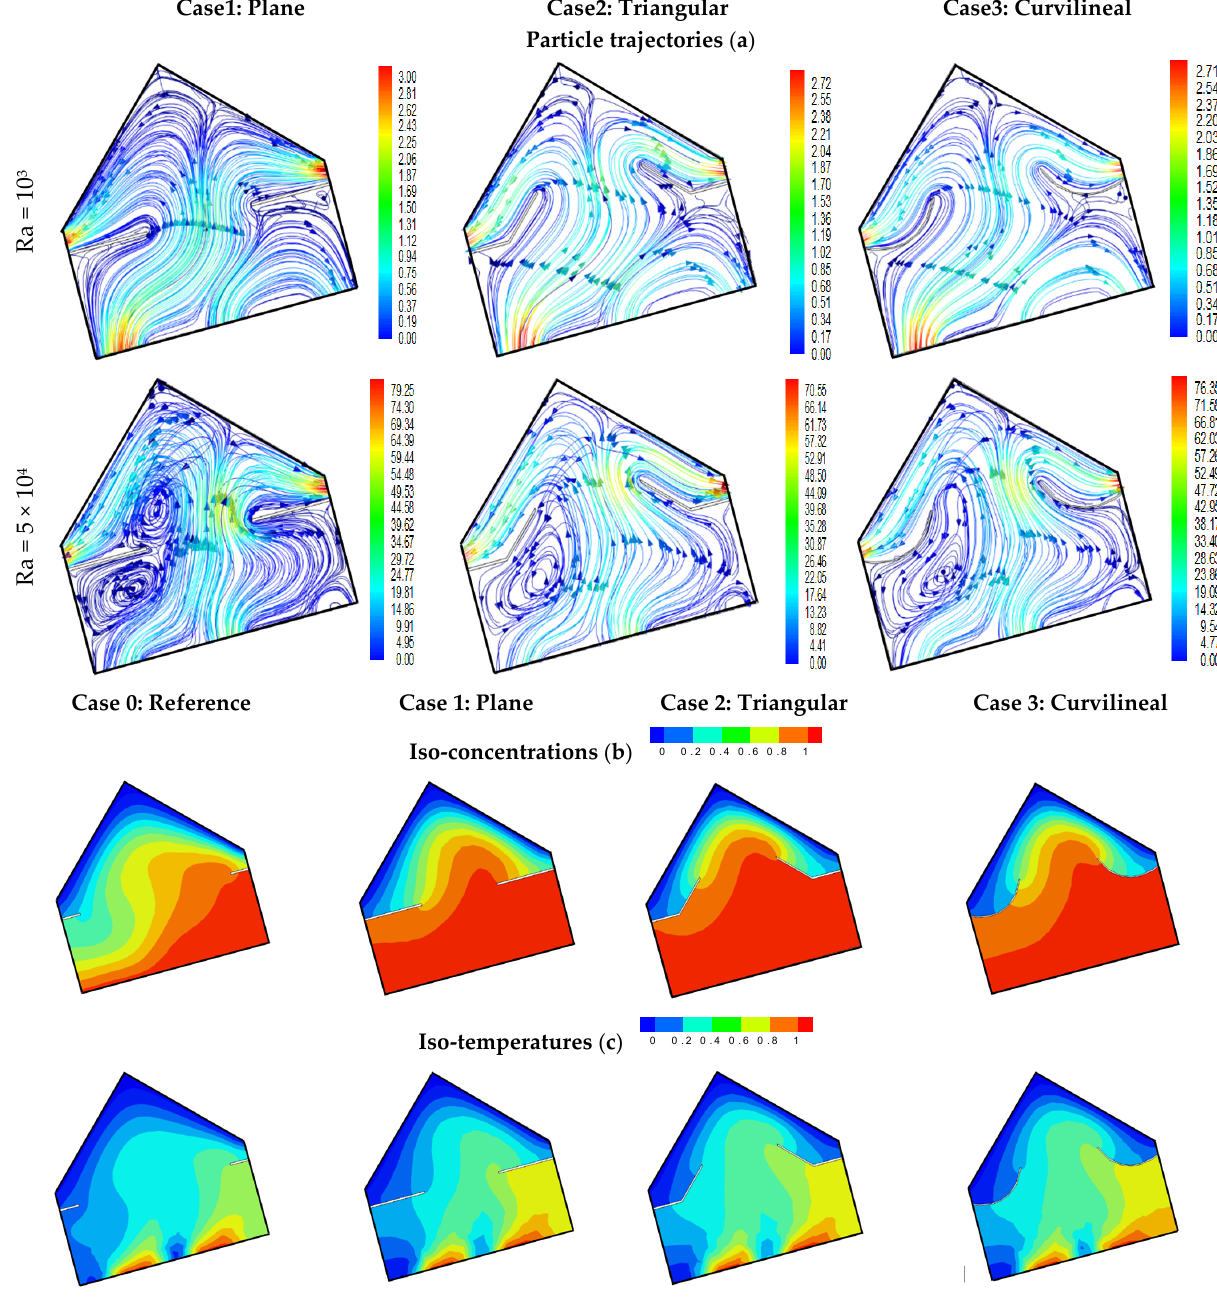
Figure 6. Particle trajectories ( a ), Iso-concentration ( b ) and iso-temperature ( c ), for z = 0.5 N = 0, θ = 15° and Ra = 5 × 10 4 .